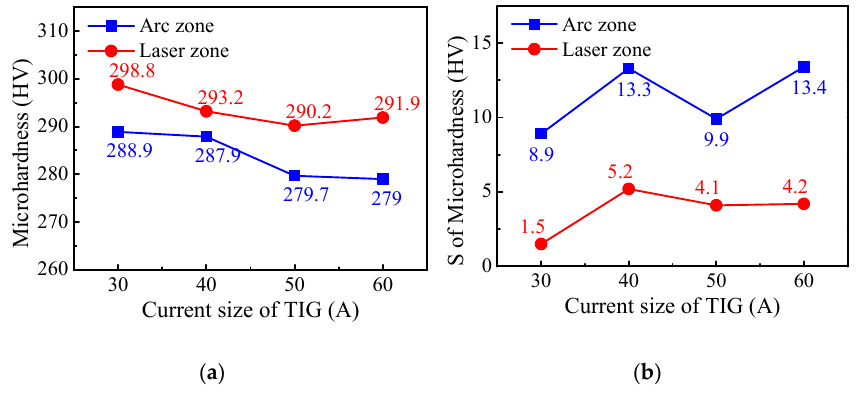
Figure 15. Microhardness value of the weld: ( a ) average microhardness value of the arc zone and laser zone; ( b ) standard deviation (S) value of microhardness in weld with different currents.